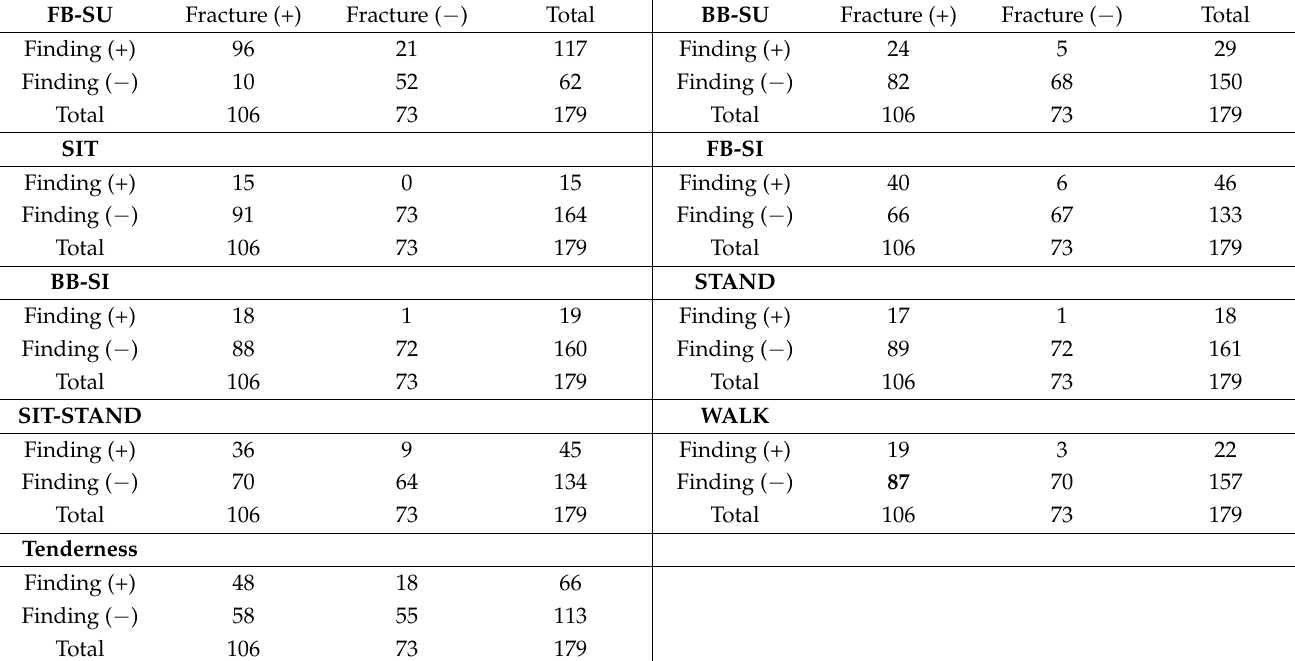
Table 3. Cross-tabulation (2 × 2) diagram of index physical